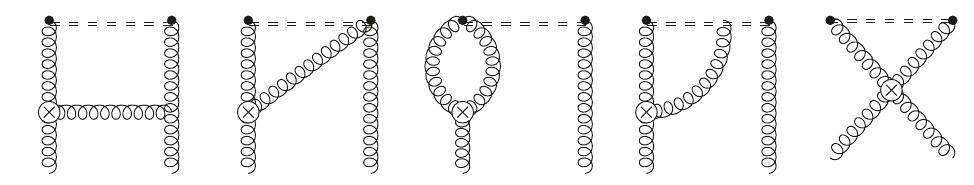
Figure 2 . Gluon diagrams generated by the contribution in eq.